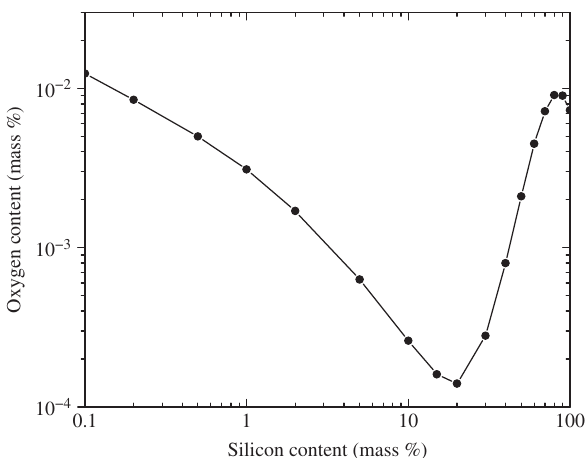
Figure 2: Oxygen solubility in Fe – Si melts in equilibrium with silica at 1,873